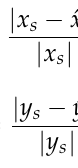
Table 1. Location data of the AE sources based on the EKF method and their corresponding group velocities.